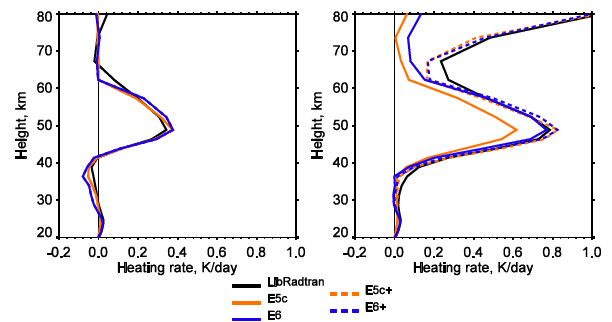
Figure 7. Shortwave heating rate differences (solar max minus so- lar min) of the 11-year solar cycle in Kday − 1 for tropical standard atmosphere and solar zenith angle equal to 10 ◦ . Left panel: includ- ing only ozone changes. Right panel: UV + ozone changes. Original codes results are denoted by solid lines, improved codes results by dashed